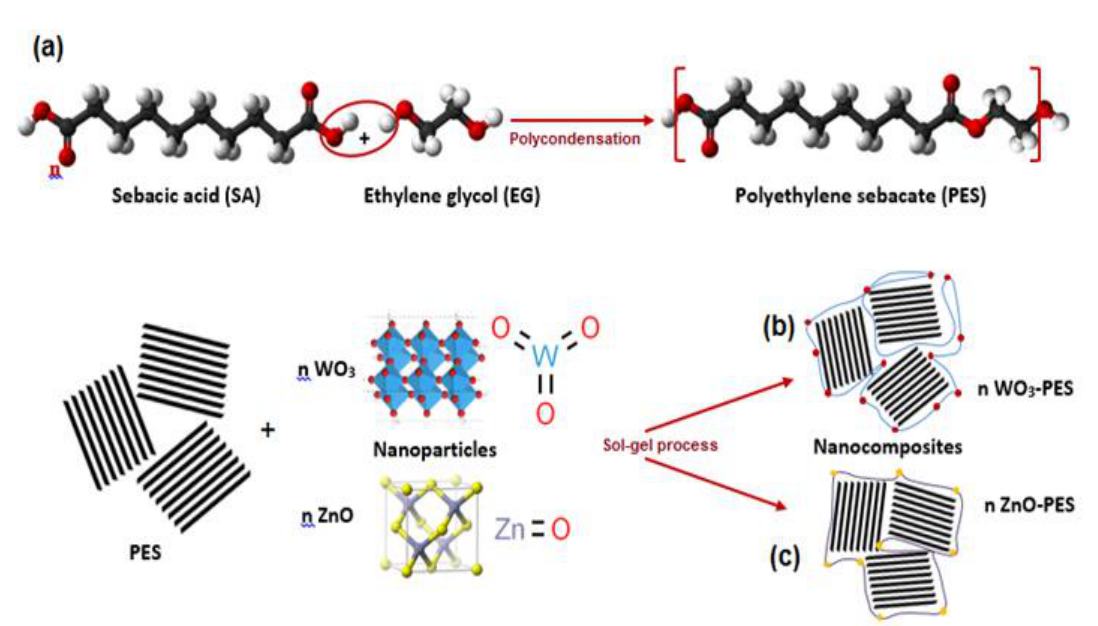
Figure 1. Sequence-based modeling of ( a ) PES, ( b ) PES-WO 3 NC, and ( c ) PES-ZnO NC .